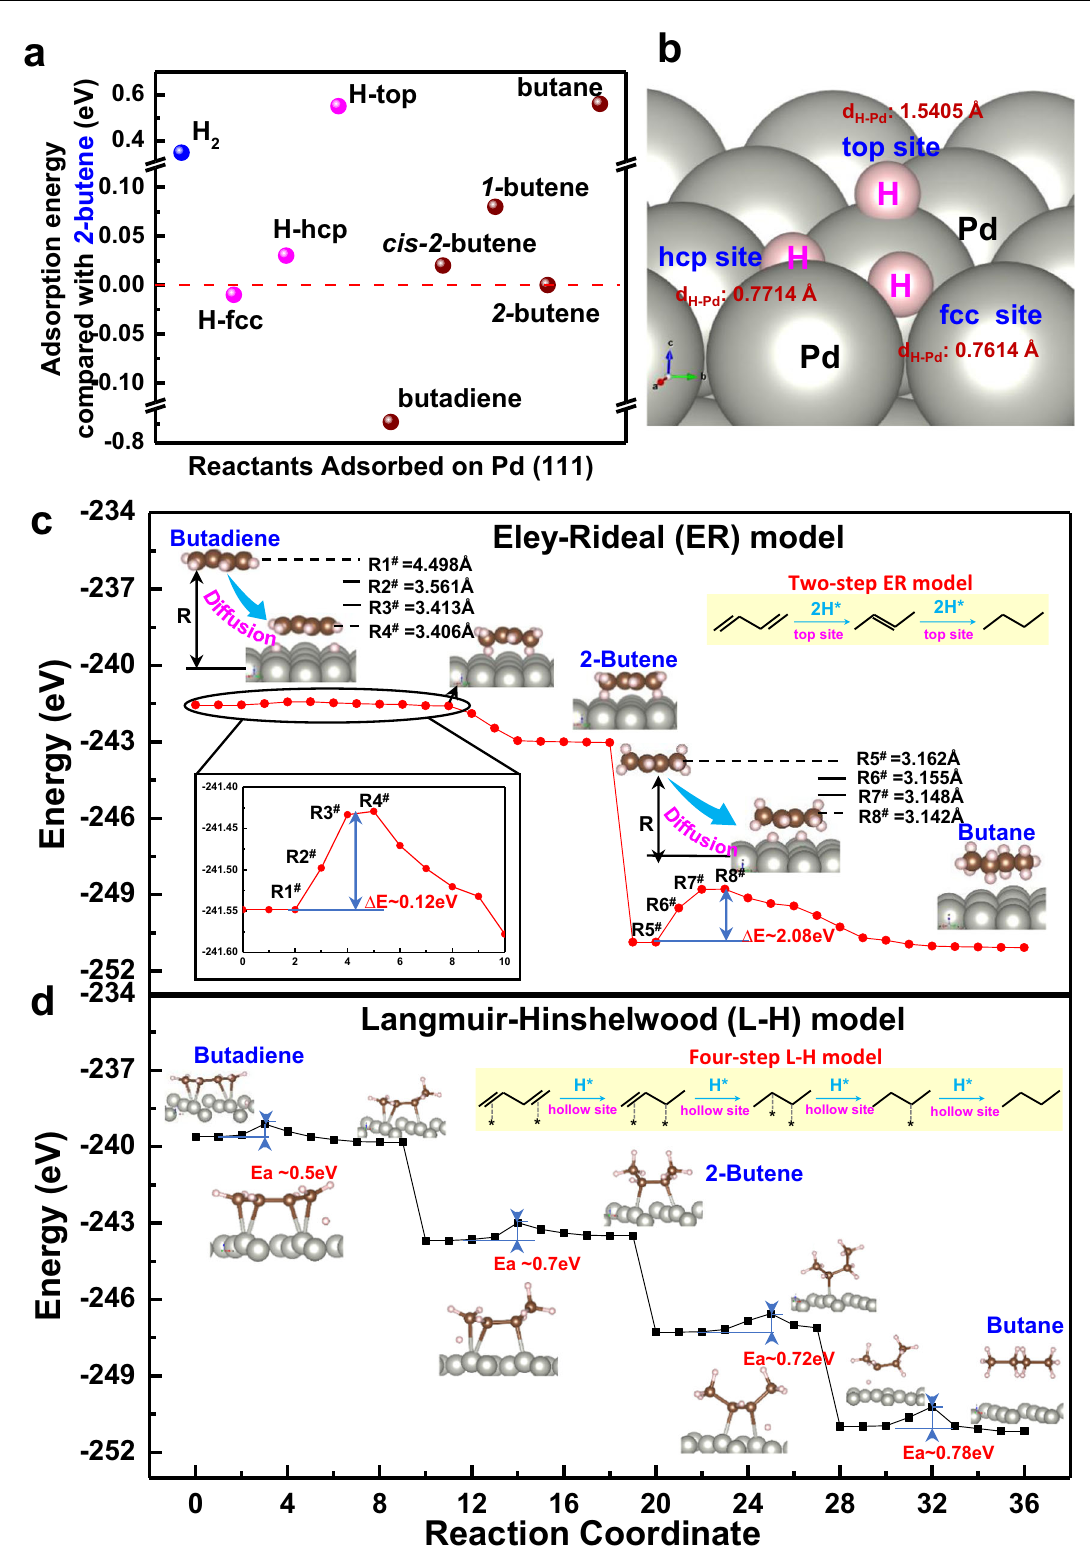
Fig. 4 | DFT calculation on the energy evolution in butadiene hydrogenation. a The adsorption energy of reaction species with 2-butene as the baseline on Pd (111) surface. b the state of H on different sites of Pd (111). c The Eley-Rideal model of reaction. d The Langmuir-Hinshelwood model of packing of hydrogen atom with Pd atom generates a steric-hindrance reacting with the adsorbed hydrogen atoms (i.e., the L-H model). As from Pd atom to the catalytic reaction between adsorbed hydrogen seen in Fig. 4c, the adsorbed butadiene reacts with hydrogen atoms atoms and gas-phase butadiene molecules. This leads to the conclu- (H a ),resulting inCH 2 = CH-CH * -CH 3 asintermediate and then adsorbed 2-buteneassemi-hydrogenationproduct,withEaof~0.5eVand0.7eV, sion that butadiene molecules must be adsorbed on Pd surface before